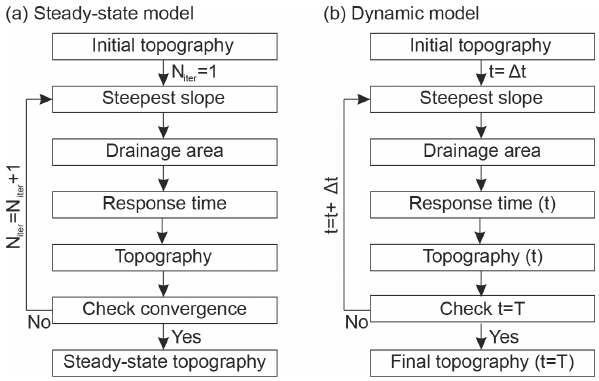
Figure 1. Overview of the algorithms used for the (a) steady-state and (b) dynamic